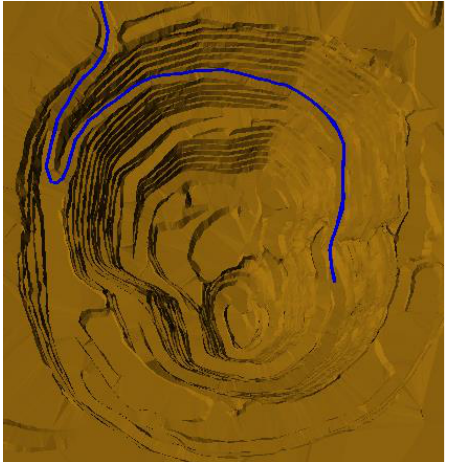
Figure 5. View of the road inside an open pit mine.